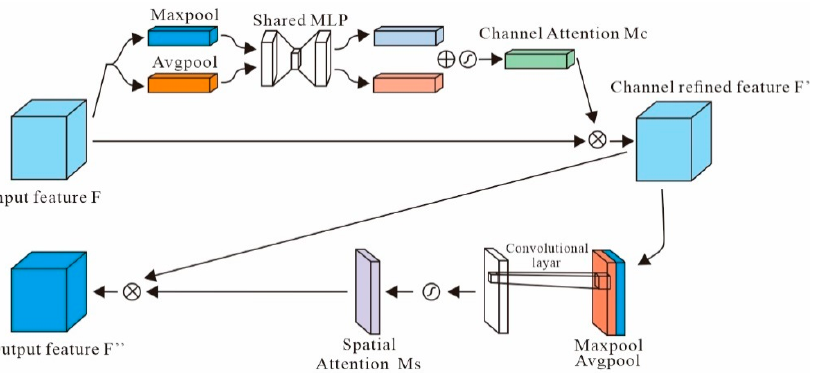
Figure 4. Attention mechanism. The CBAM (convolutional block attention module) contains two sub-modules—channel and spatial. The channel attention uses the maximum pooling and the average pooling to provide the features, and the MLP (multi-layer perception) combines them to finish the channel attention sub-module. The spatial attention sub-module uses the maximum pooling and the average pooling without MLP but puts them in the convolution layer to finish the spatial